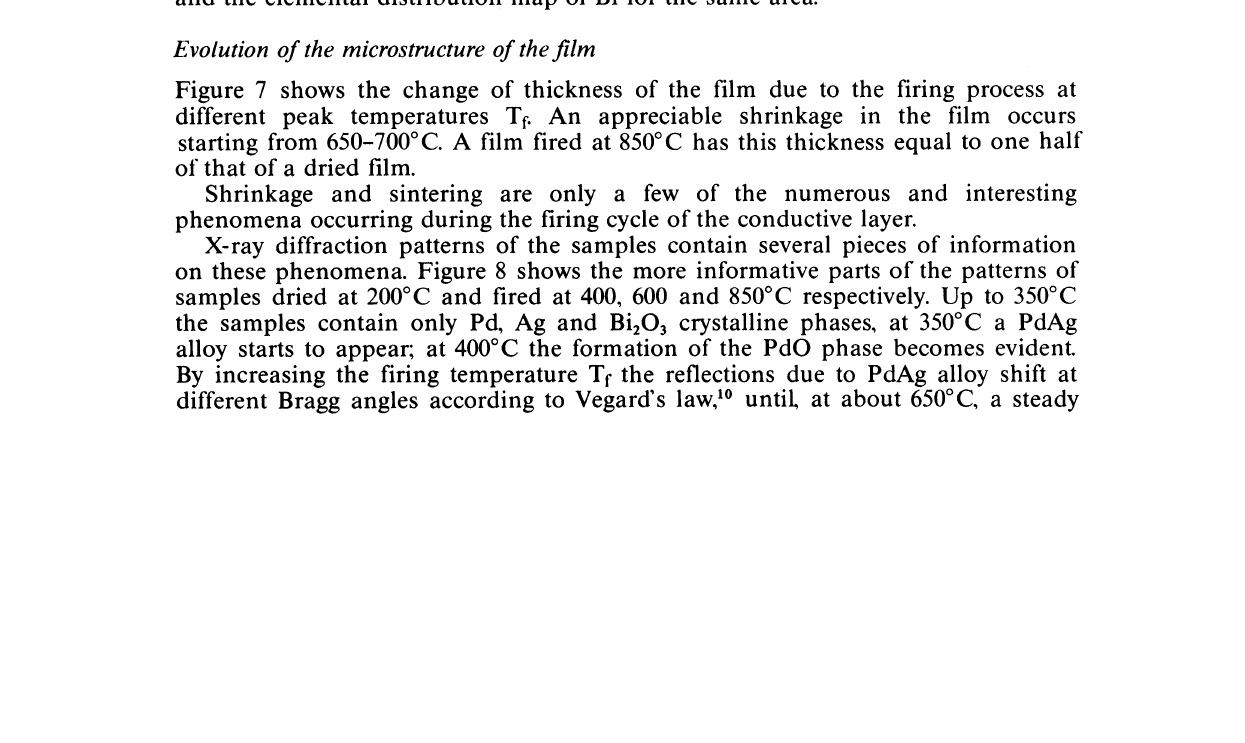
0 39 3t3 37 Degree 2 FIGURE 5 Diffraction pattern of d) peaks of Ag and Pd grains in the paste dried at